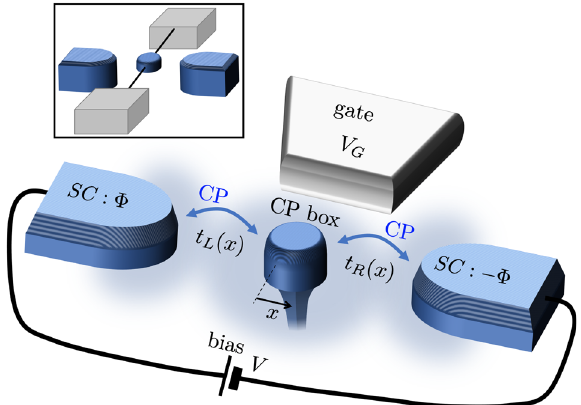
Fig. 1 Schematic presentation of the proposed junction. There are two bulk superconducting contacts with phases ± Φ biased by voltage V with a superconducting island (Cooper pair box — CPB) in between. t L ( R ) ( x ) are the tunneling amplitudes for the Cooper pairs between the leads and the CP box, dependent on position x . V G is the gate voltage. Two possible con fi gurations are presented: the CPB island on the top of the oscillating cantilever (main fi gure), and the CPB island attached in the middle of the suspended oscillating nanowire with V G provided via the substrate (inset). For equivalent electrical circuit see Supplemental material, Section I, Fig.